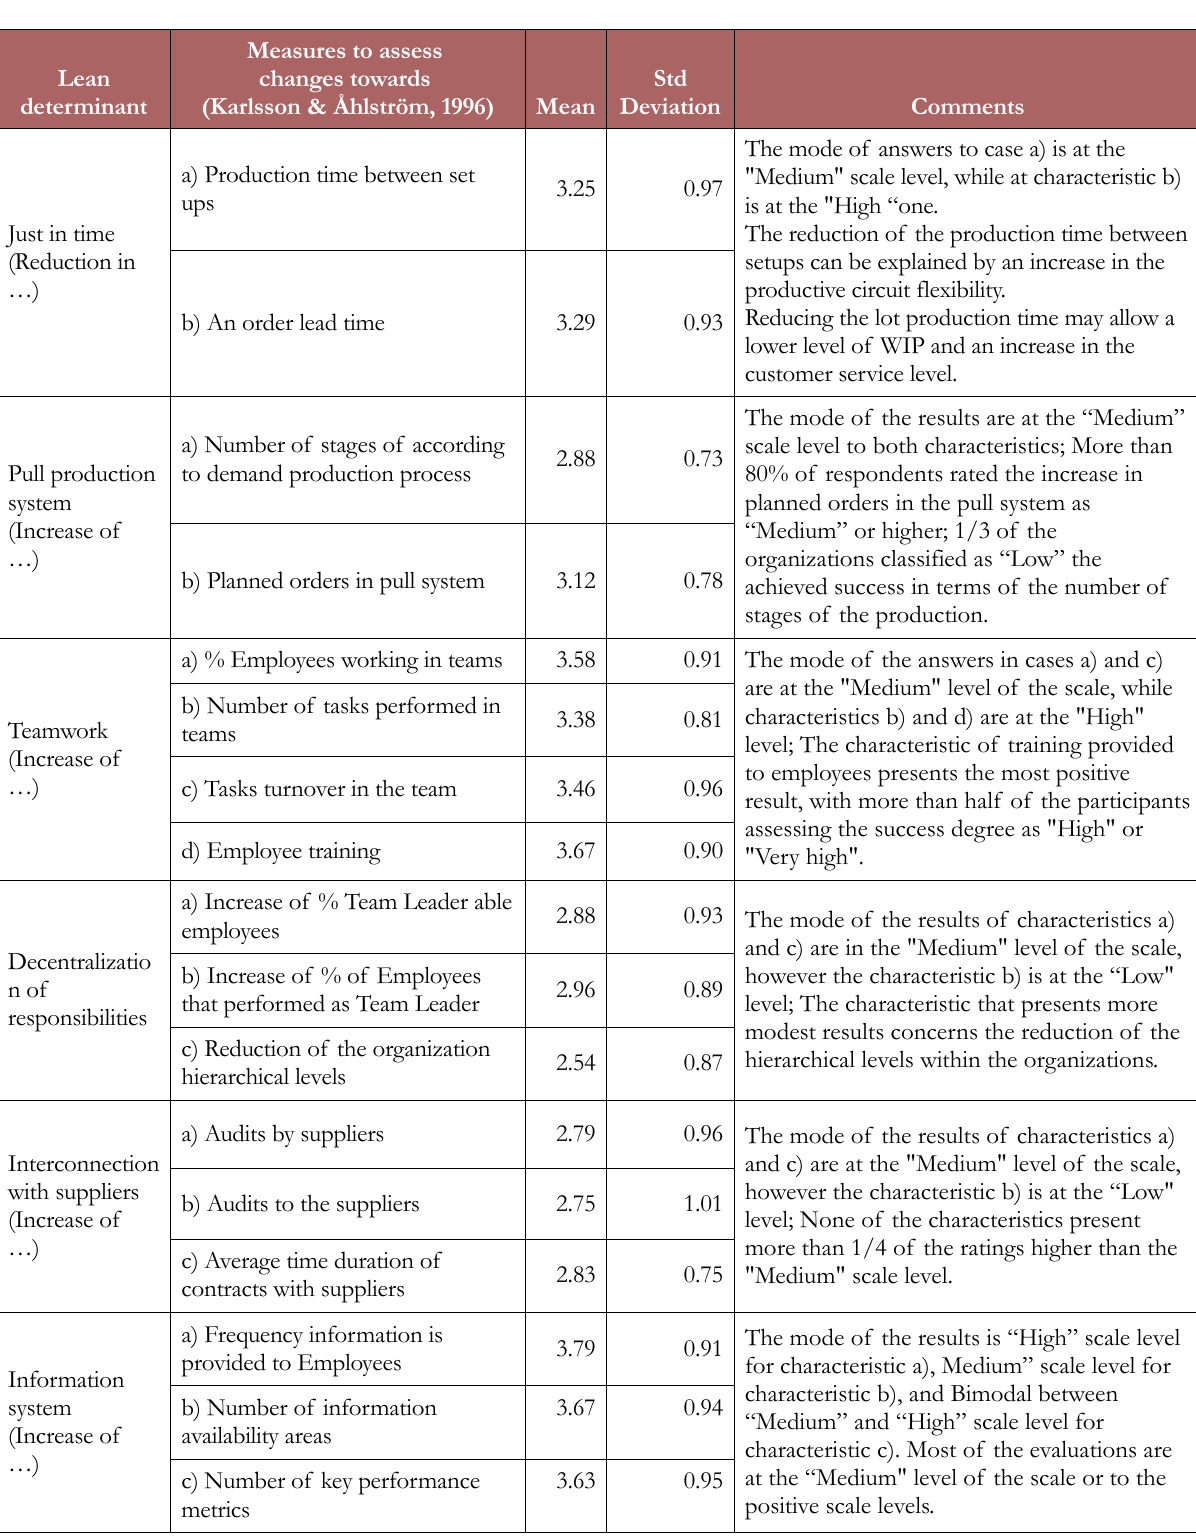
Table 4. Descriptive statistics for Lean determinants and assessment